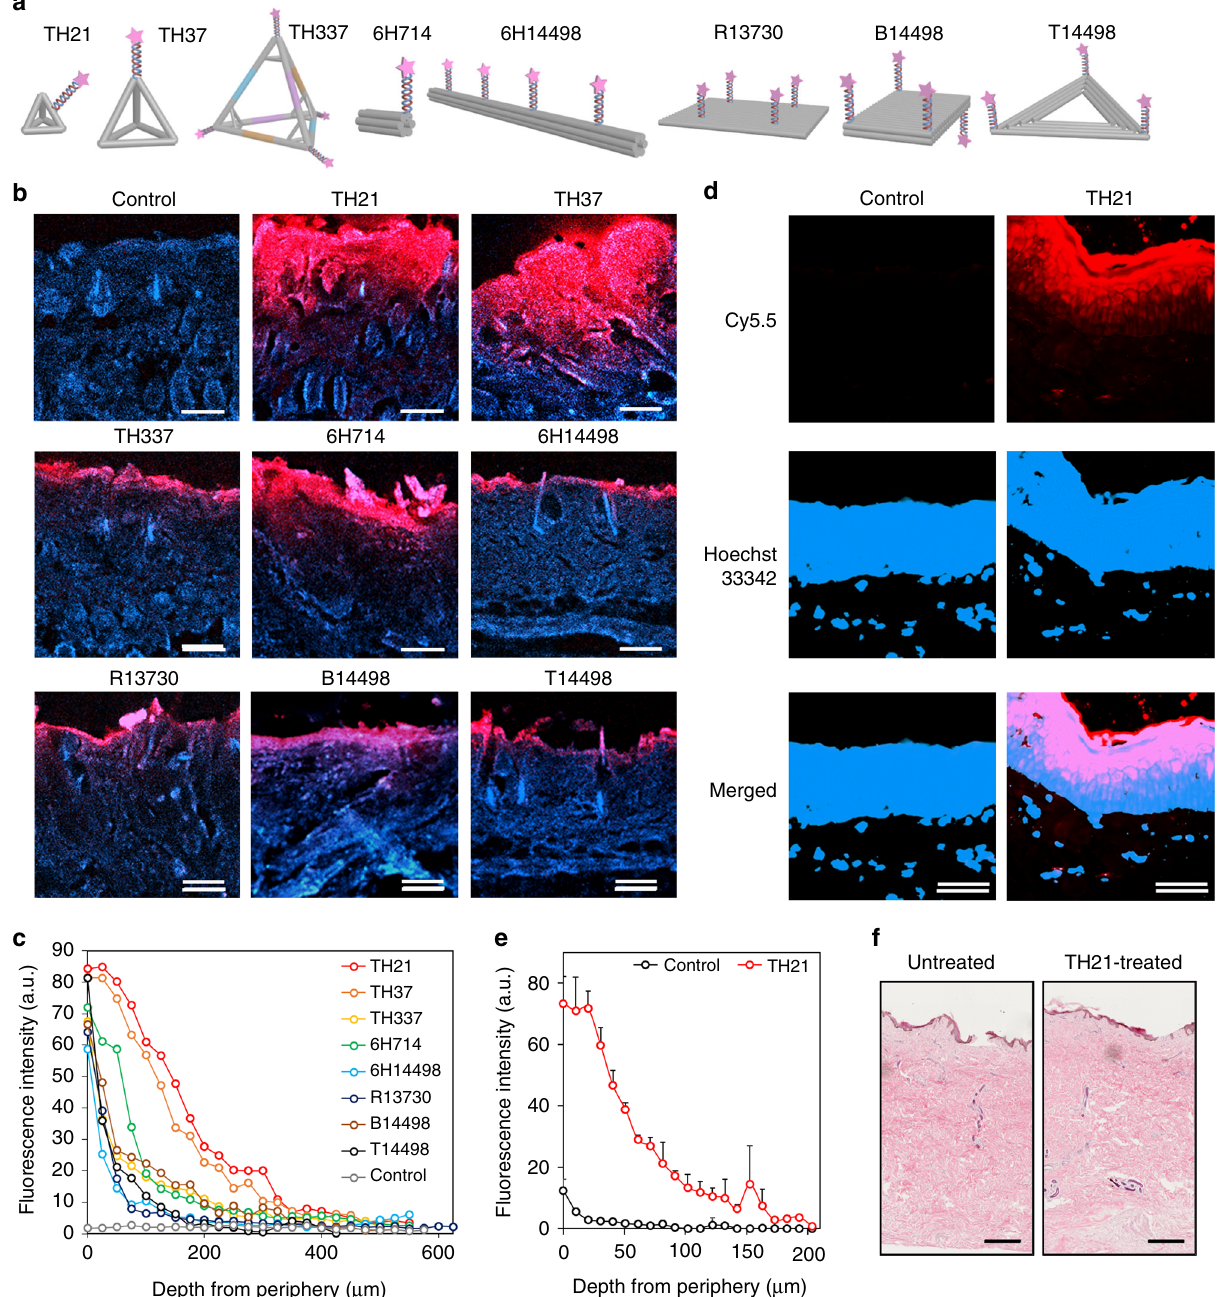
Fig. 2 Topical delivery and penetration of FNAs through mice and human skin: a Schematic illustration of 8 kinds of FNAs (not drawn to scale). b Representative fl uorescence images of mouse skin histology post various FNAs penetration (24 h; red: Cy5.5-tagged FNAs, blue: Hoechst33342-stained skin); c pro fi le of Cy5.5 fl uorescence signal from FNAs along skin depth in b . d Representative fl uorescence images of human skin explant histology post TH21 FNA penetration (24 h; red: Cy5.5-tagged FNAs, blue: Hoechst33342-stained skin); e pro fi le of fl uorescence signal from Cy5.5-TH21 FNA along human skin depth in d . f Hematoxylin & eosin staining showing TH21 treatment minimally affects human skin morphology (left: untreated skin, right: TH21- treated skin). Source data are provided as a Source Data fi le. Scale bar: 200 μ m. Error bars represent standard